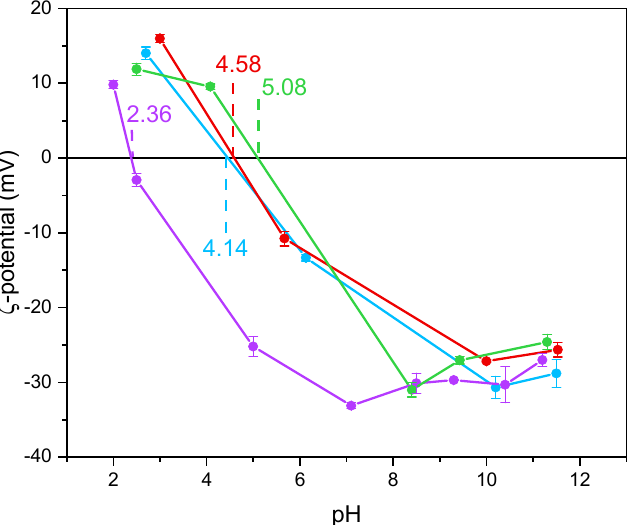
Figure 4. ζ -potential curves obtained by measuring the electrophoretic mobility as a function of pH obtained with the undoped TiO 2 (purple line), Fe(3.5)-TiO 2 (green line), Fe(2.5)-TiO 2 (red line), Fe(1.0)-TiO 2 (light blue line). For each point, an average of three measures is reported, with the related error bar.